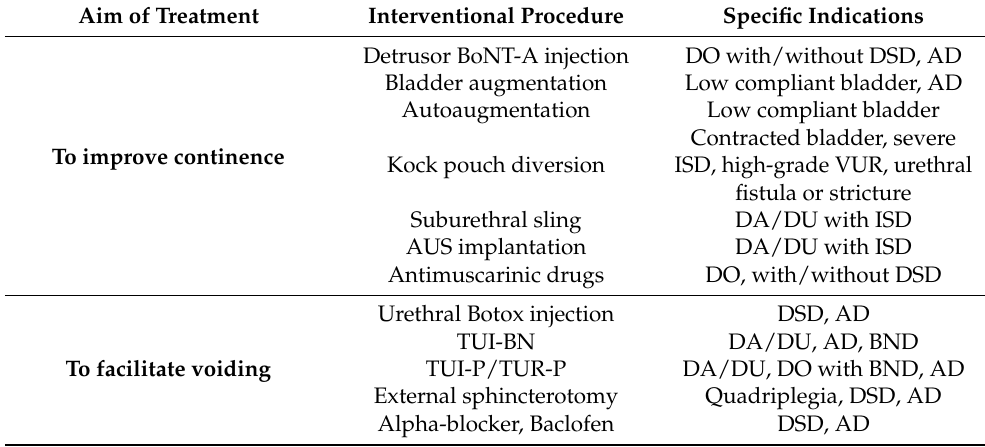
Table 2. Treatments and surgical procedures for neurogenic lower urinary tract dysfunction in chronic spinal cord-injured